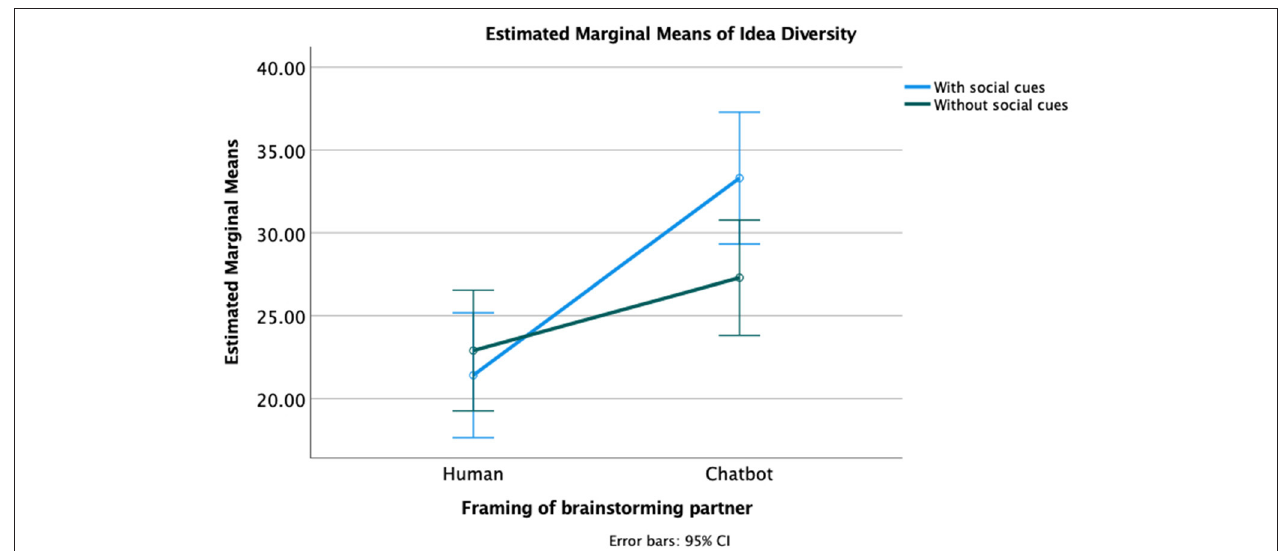
FIGURE 2 | The interaction effect between brainstorming partner and social cues on idea